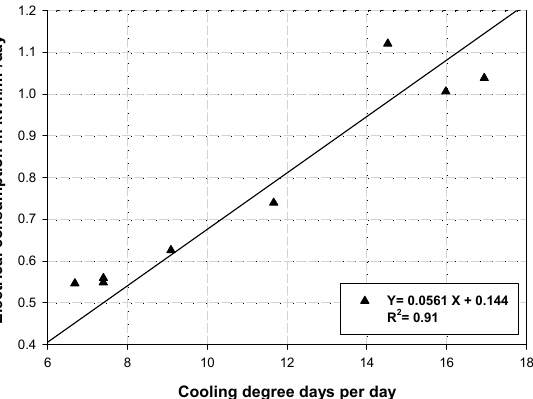
Figure 4. Electrical consumption in kWh/m 2 /day versus cooling degree-days per day for the University of Jeddah Campus from July 2018 to March 2019 with energy control policy applied. A linear fit and correlation are shown.